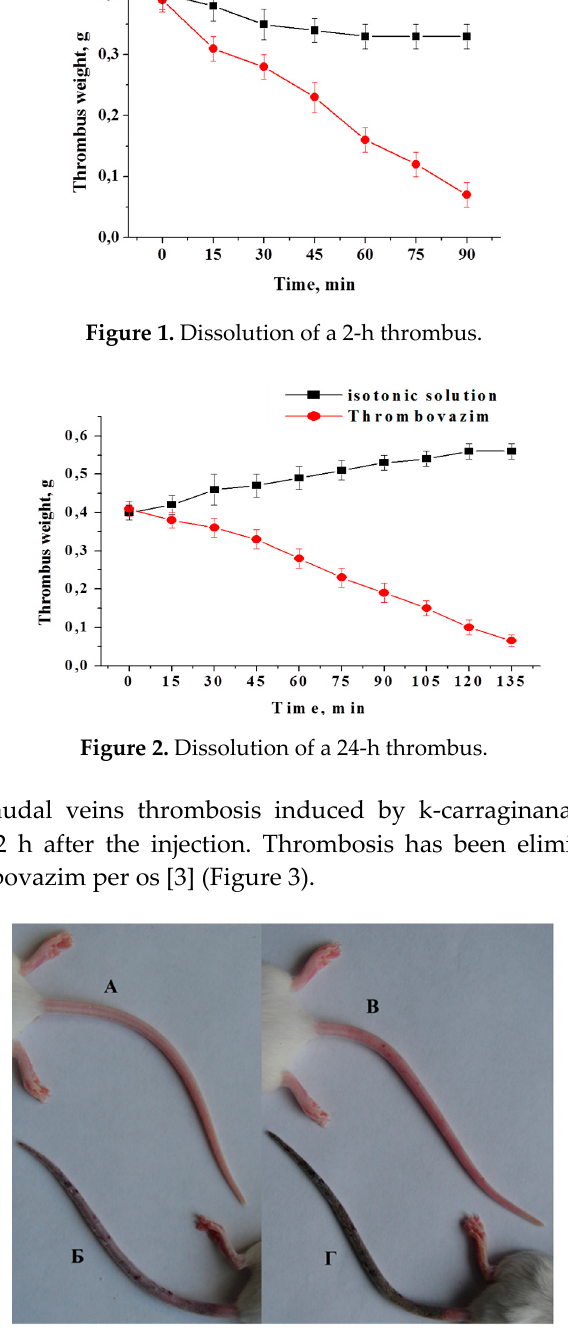
Figure 3. The rat model of tail veins thrombosis, induced by k-carraginan: А . Intact animals; Б . Animals 12 h after subcutaneous administration of k-carrageenan; В . Animals after 36 h after oral administration of Trombovazim; Г . Animals without treatment, after 36